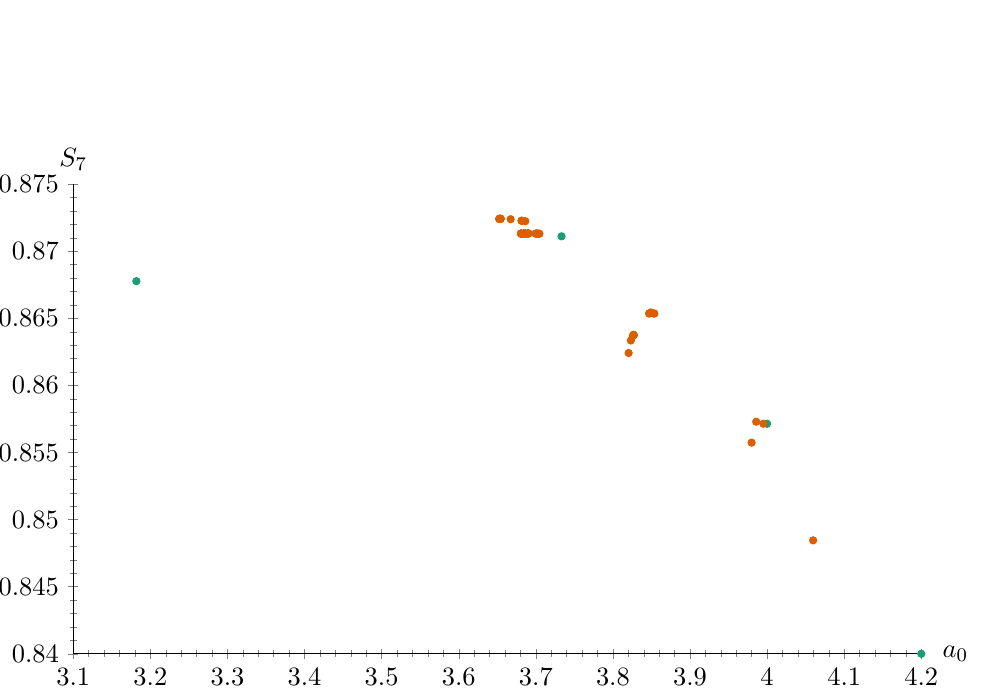
Figure 4. Fully-interacting fixed points for N = 7 . The leftmost point corresponds to T 7+ and the rightmost to O(7)